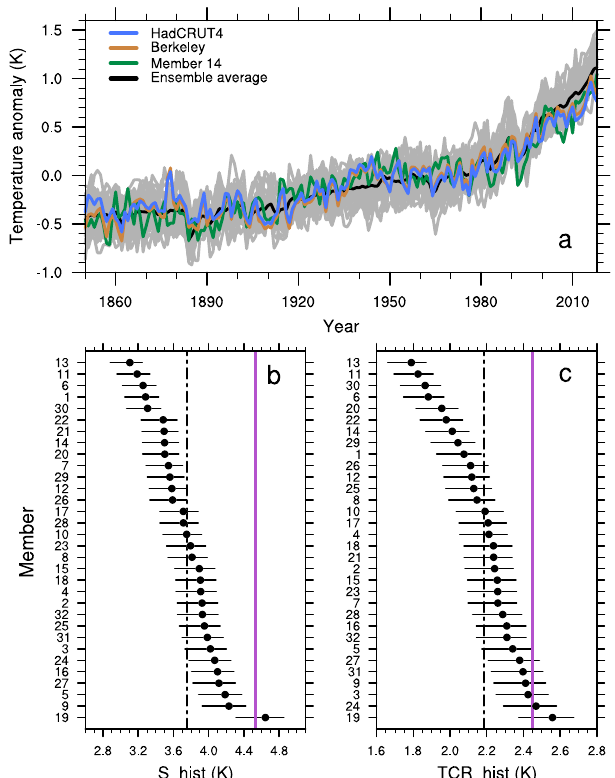
Fig. 1 Sensitivity of IPSL-CM6A-LR over the historical period. a Global mean near-surface air temperature (GSAT) anomaly (K) relative to the 1880 – 2018 period for the ensemble average (black), individual members (gray), and member #14 (green) of the IPSL ensemble of extended historical simulations (IPSL-EHS), the in fi lled HadCRUT4-CW 41,42 (blue) and the Berkeley 45 observational datasets (brown). b The climate sensitivity calculated over the historical period (S_hist, in K) for each individual member of the IPSL-EHS ranked from the lowest to the highest value (see Methods). The black dot-dashed line indicates the ensemble mean of S_hist values and the purple line indicates the Equilibrium Climate Sensitivity (ECS) value 13 of the IPSL-CM6A-LR model. c Same as b but for the transient climate response calculated over the historical period (TCR_hist, in K), the purple line indicating the Transient Climate Response (TCR) value 13 of IPSL-CM6A-LR. Error bars in b and c are calculated using the lowest and largest values of the forcing due to a doubling in atmospheric CO 2 concentration (see Methods for more